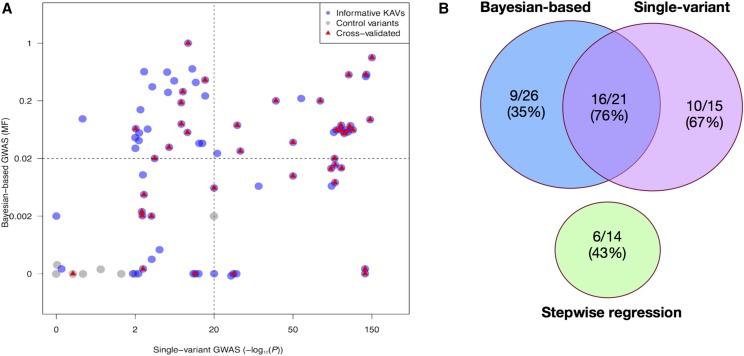
Genetic validation results of selected kernel row number associated variants (KAVs). (A) Transformed P values using single variant (SV) model and posterior model frequencies using Bayesian-based multi-variant (BMV) model were extracted and plotted for the 77 informative KAVs identified by at least one of the three GWAS models. KAVs detected only by the SV model are plotted in the lower right quadrant, KAVs detected only by the stepwise regression model are plotted as non-gray dots in the lower left quadrant, the KAVs detected only by the BMV model are plotted in the upper left quadrant, KAVs detected by both the SV and BMV models are plotted in the upper right quadrant and control variants are plotted as gray dots in the lower left quadrant. Validated KAVs are marked in red. A control variant is a genomic variant that is randomly chosen from a set of SNPs that were not associated with KRN in the initial GWAS. (B) Venn diagram of the validation results.